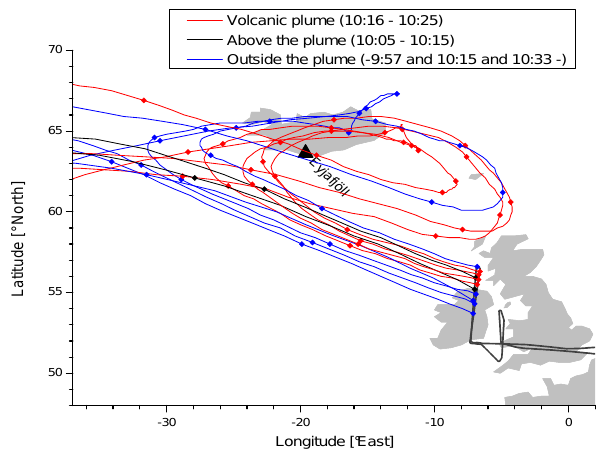
Fig. 4. TRAJKS backward trajectories, for the time of the CARIBIC plume observation. The dots along the trajectories la- bel 12 hours intervals. With the DOAS the plume was observed twice, as the aeroplane crossed over the plume and subsequently descended to the plume altitude (Sec. 3.2 and 3.3). The trajecto- ries for the period during which many other instruments showed influence of volcanic air masses are illustrated in red, the blue lines show clean air, and the black lines stand for the periods of enhanced DOAS SO 2 signal without additional indicators for volcanic influ- ences. The origin of the enhanced SO 2 values can be traced back to the Eyjafjallaj¨okull volcano on Iceland, which the air masses had passed 34–53 hours before CARIBIC sampled the plume (16 May 2010 10:20 UTC).